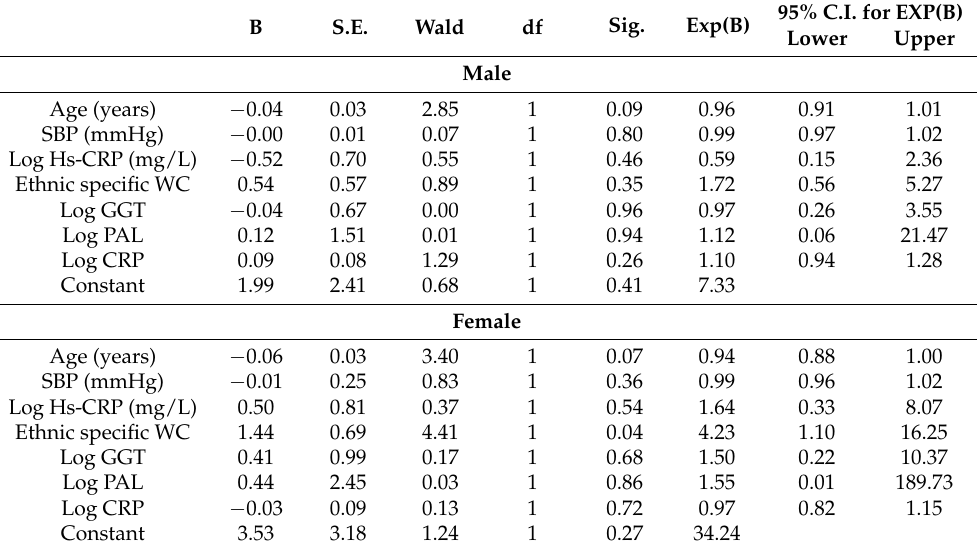
Table 6. Logistic regression analysis to assess the probability of central adiposity to predict subclinical atherosclerosis in a male and female teachers’